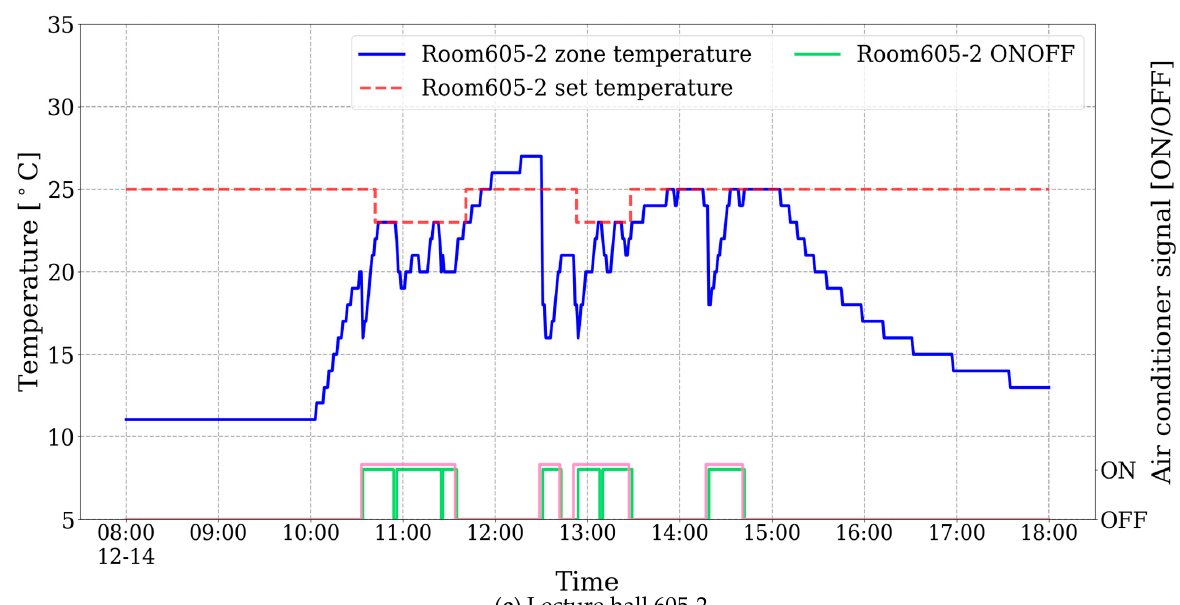
Figure 19. Reduction ratio 10% result of the field test with the zone temperature, set temperature, and air conditioners operating state applying the building control algorithm. ( a ) Lecture hall 202-2; ( b ) Lecture hall 305-2; ( c ) Lecture hall 404; ( d ) 5F lounge 1; ( e ) Lecture hall